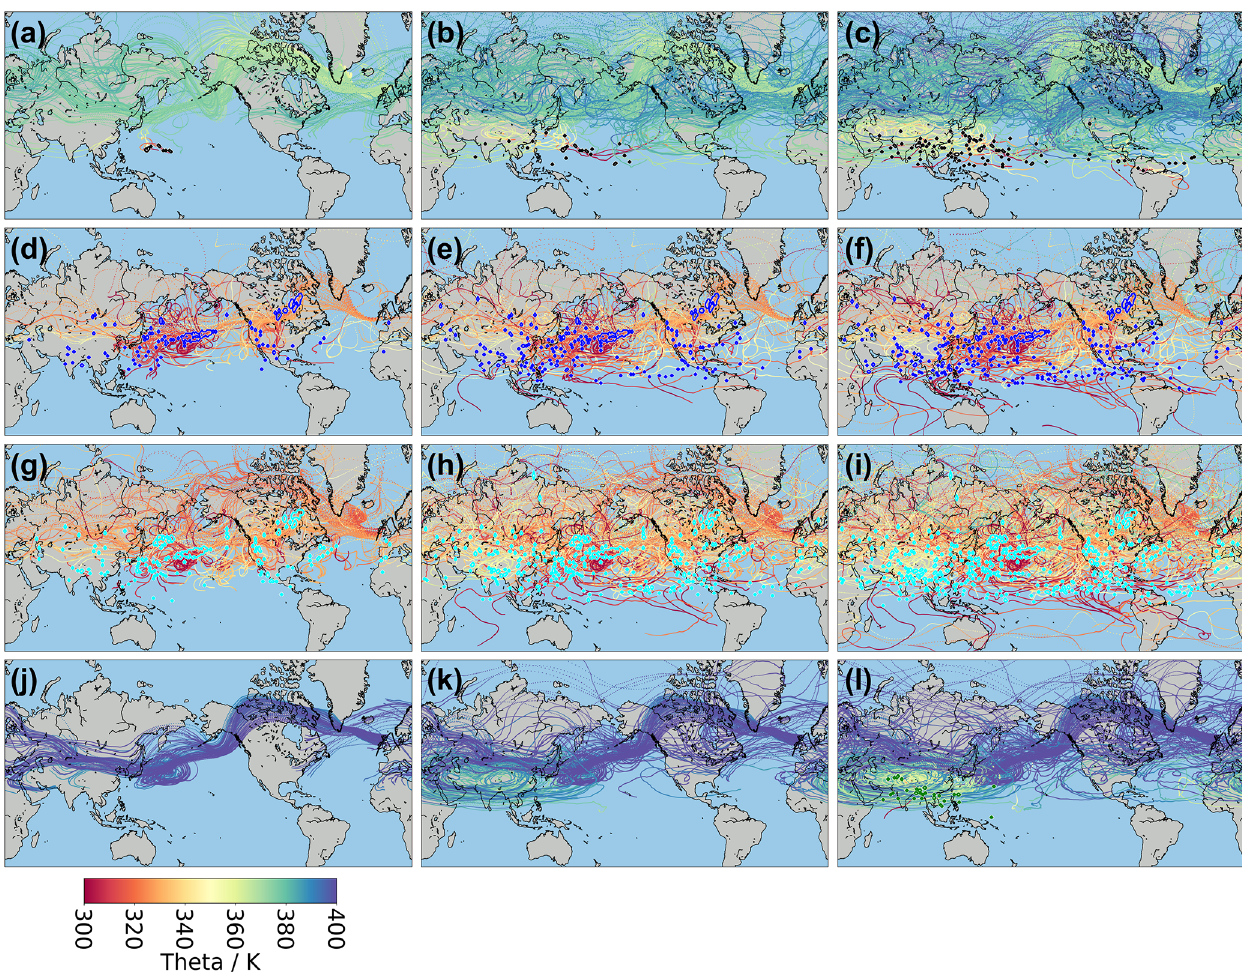
Figure 9. Backward trajectory calculations performed by CLaMS using ERA-Interim wind data. Trajectories start at the GLORIA tangent points and are shown for 20d (left column), 40d (middle column), and 60d (right column) within defined regions: black (a–c) , blue (d–f) , cyan (g–i) , and green (j–l) as displayed in Fig. 6. Trajectory colours denote the potential temperature (which is also a measure of altitude) along the trajectory as indicated in the colour bar. Coloured encircled areas (black, blue, cyan, and green) mark regions where the backward trajectory penetrates the upper edge of the planetary boundary layer (800hPa). For better clarity, only every tenth trajectory is displayed. Hence, encircled areas may occur where no trajectory is